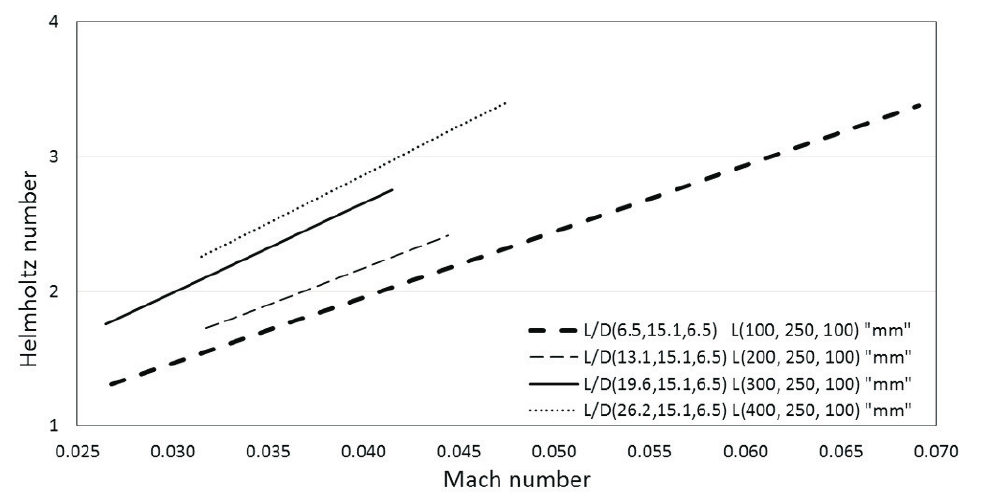
Figure 16. Helmholtz number He plotted against Mach number M for L up = 100–400 mm, L corr = 250 mm, and L dw = 100 mm. Table 12. Mach number and corresponding Helmholtz number ( He ) range for pipe systems in Case b-I. L up